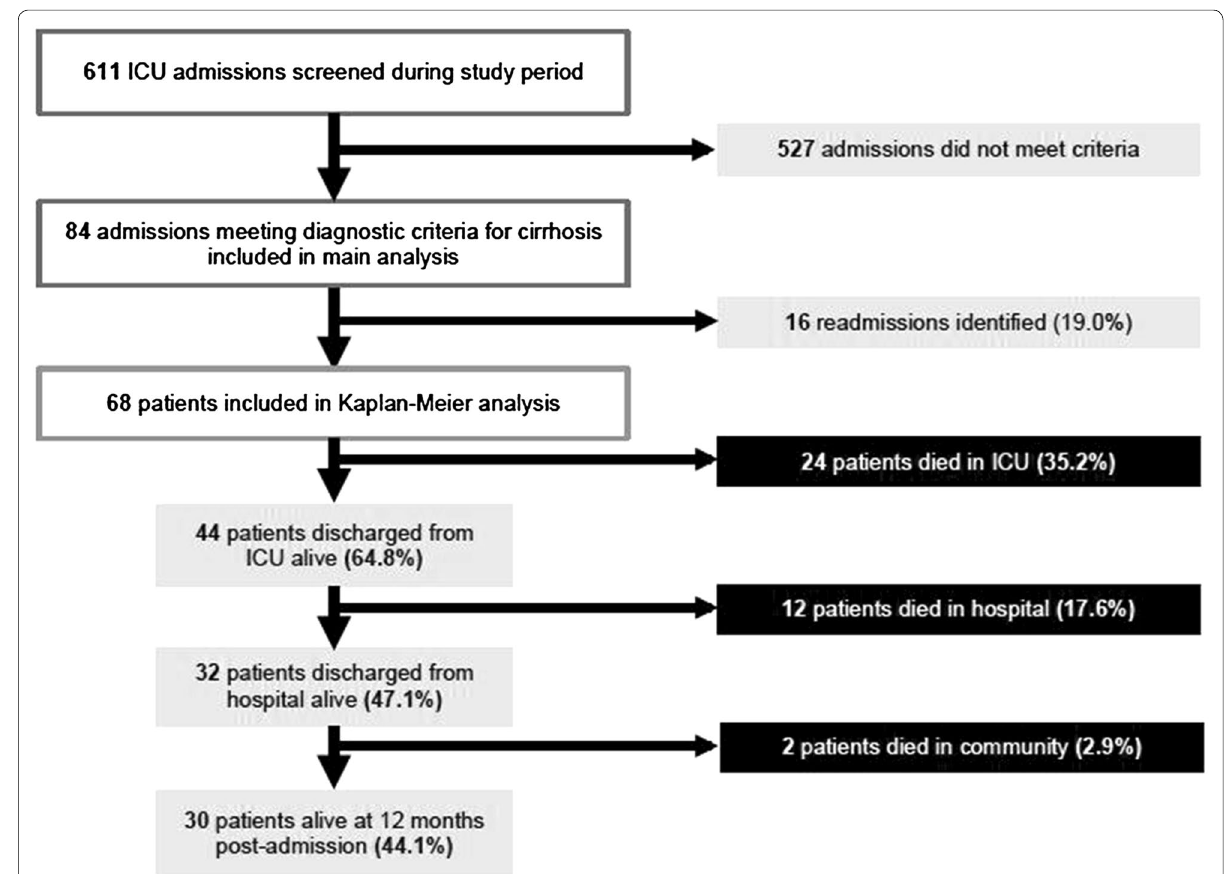
Fig. 1 Summary of 18-month observational cohort study of patients with cirrhosis admitted to a general ICU